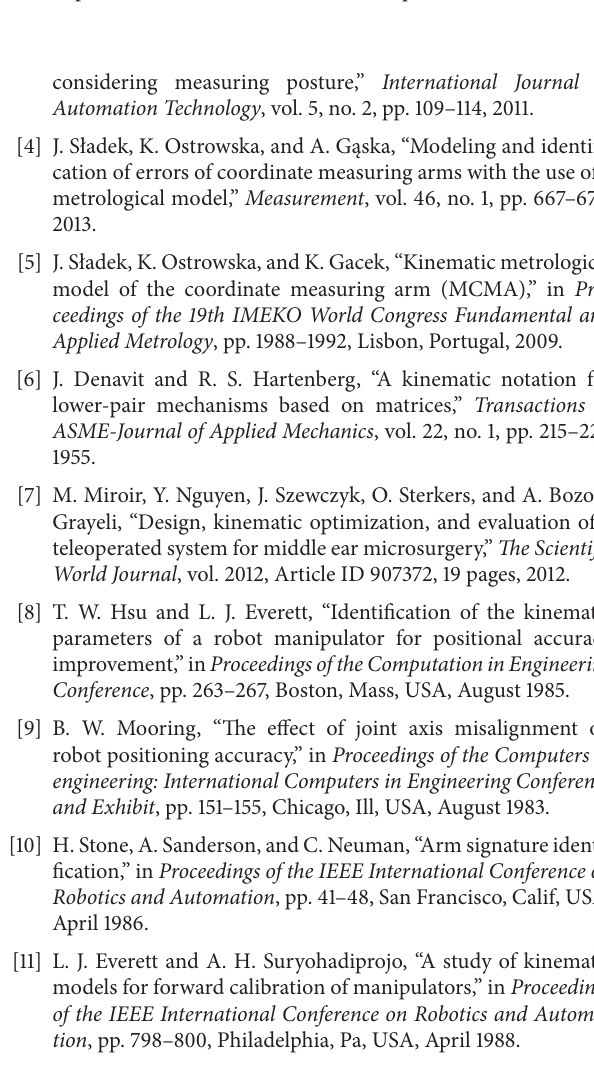
Figure 9: Points captured by the AACMM. (a) Nominal kinematic parameters; (b) identified kinematic